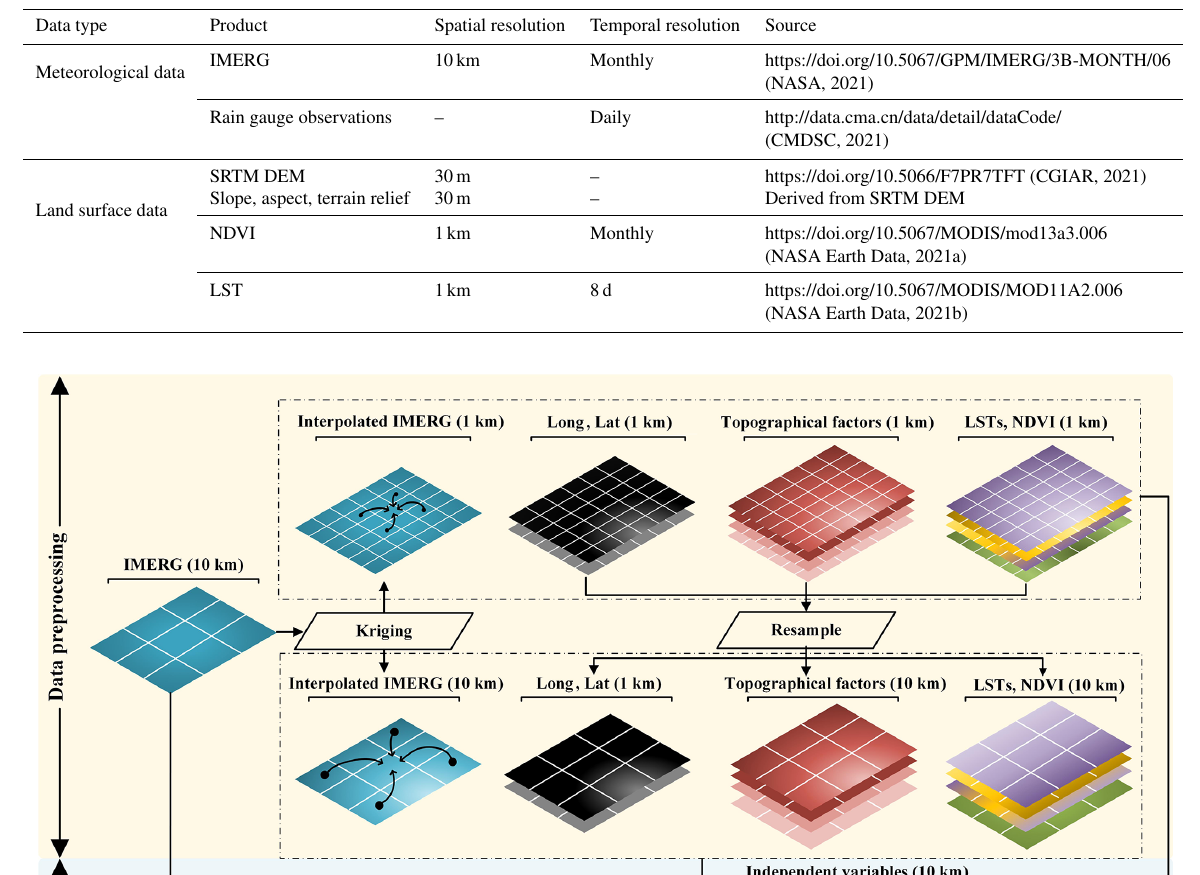
Table 1. Datasets used in the study.